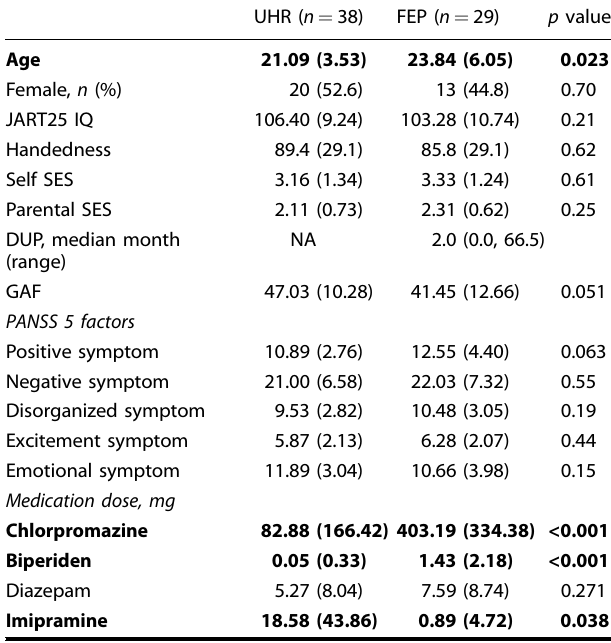
Table 1. Demographic and clinical characteristics in this